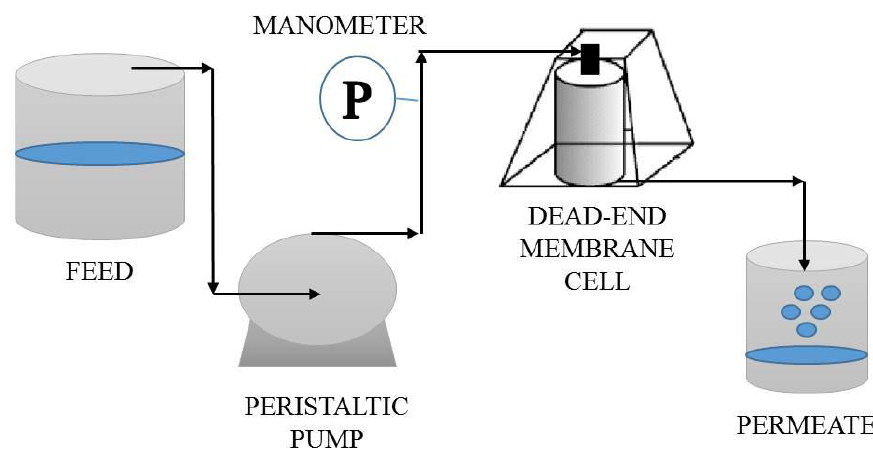
Figure 1. Experimental set up used for Arsenic (As) removal from aqueous solutions.